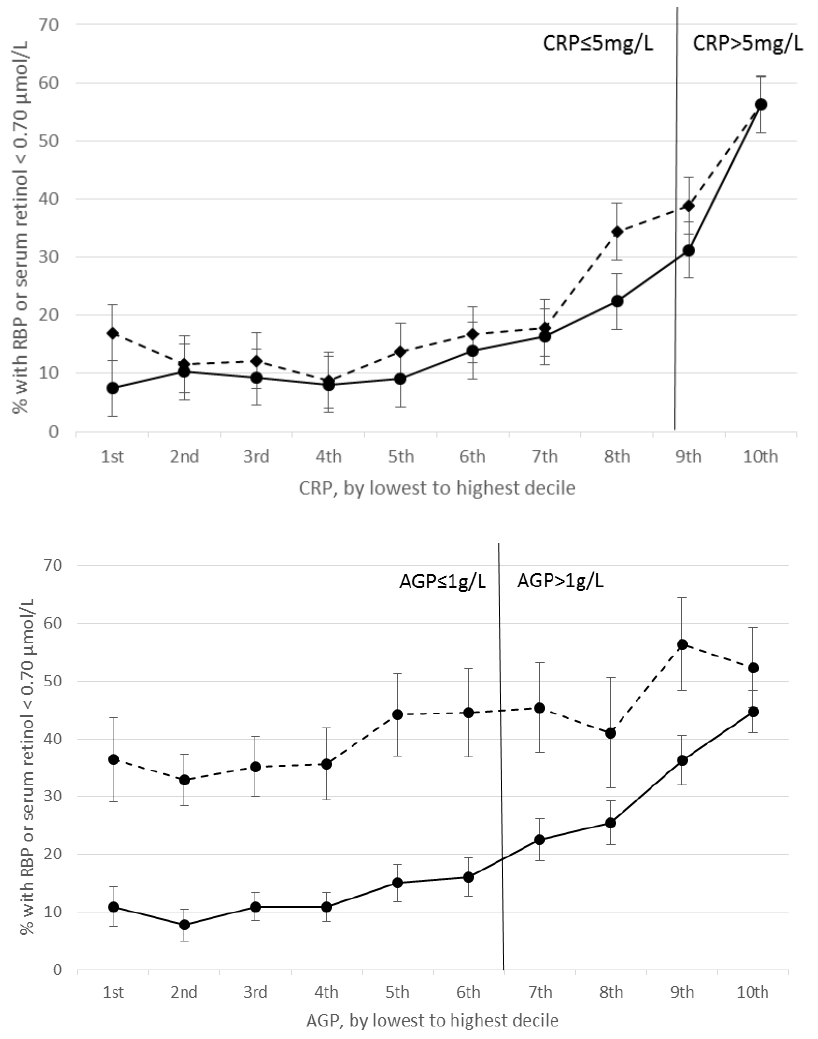
Figure 1. Estimated prevalence (95% CI) of vitamin A deficiency in preschool age children by C-reactive protein (CRP) ( top ) and α 1-acid glycoprotein (AGP) ( bottom ) deciles. Top figure: solid line represents prevalence of retinol binding protein (RBP) < 0.70 µ mol/L ( n = 11,605), dotted line represents prevalence of retinol < 0.70 µ mol/L ( n = 9798). Bottom figure: Solid line represents prevalence of RBP < 0.70 µ mol/L ( n = 11,605), dotted line represents prevalence of retinol < 0.70 µ mol/L ( n = 10,055). AGP, α 1-acid glycoprotein; CRP, C-reactive protein; RBP, retinol binding protein.